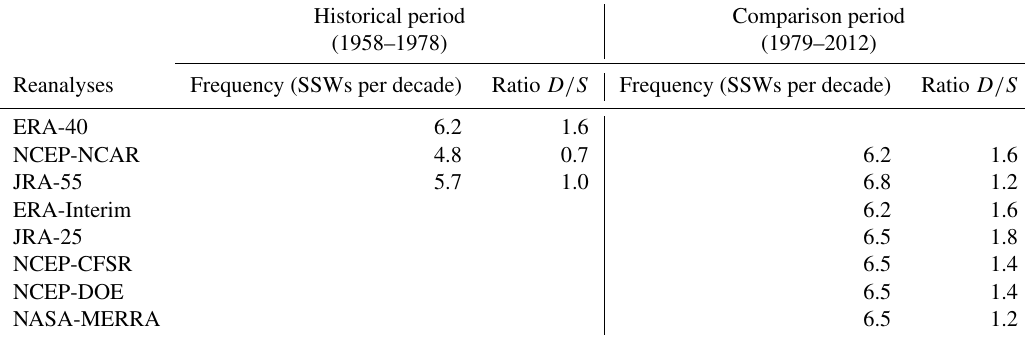
Table 2. Frequency of SSWs per decade and ratio of vortex displacement ( D ) vs. vortex split ( S ) SSWs for each reanalysis and period of